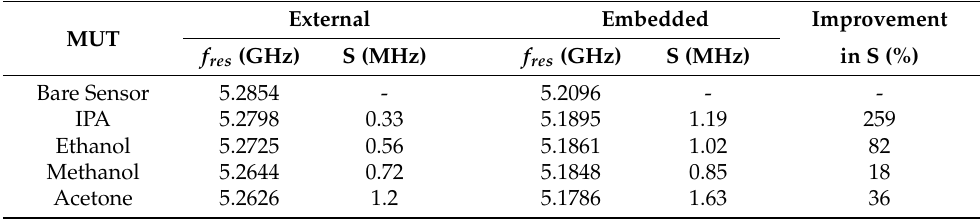
Figure 15. Microwave sensor with a tube ( a ) above and ( b ) below the sensor. ( c ) Simulation results with the sensor being loaded by a dielectric material with different permittivity values inside ( c ) an external channel and ( d ) an internal channel. Reprinted with permission from Ref. [36]. Table 3. Sensor response analysis between external and embedded channels, Reprinted with permis- sion from Ref.